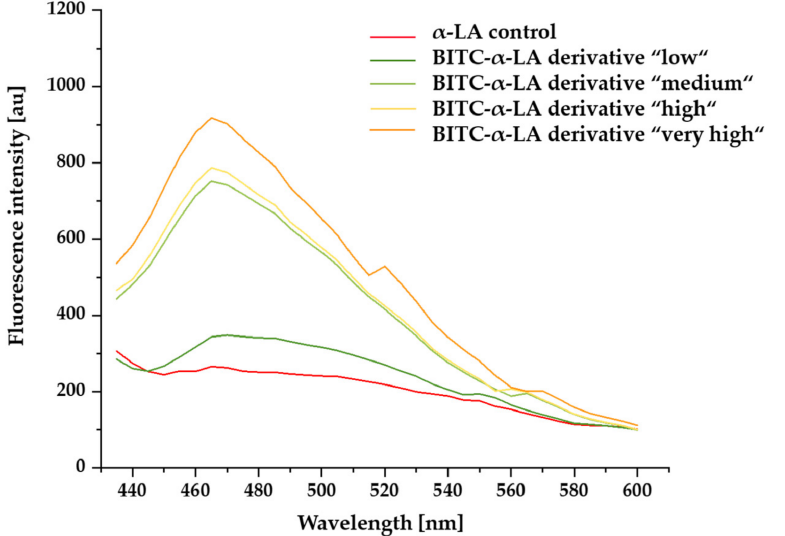
Figure 5. Mean fluorescence intensities versus wavelength of the ANS assay of the BITC- α -LA